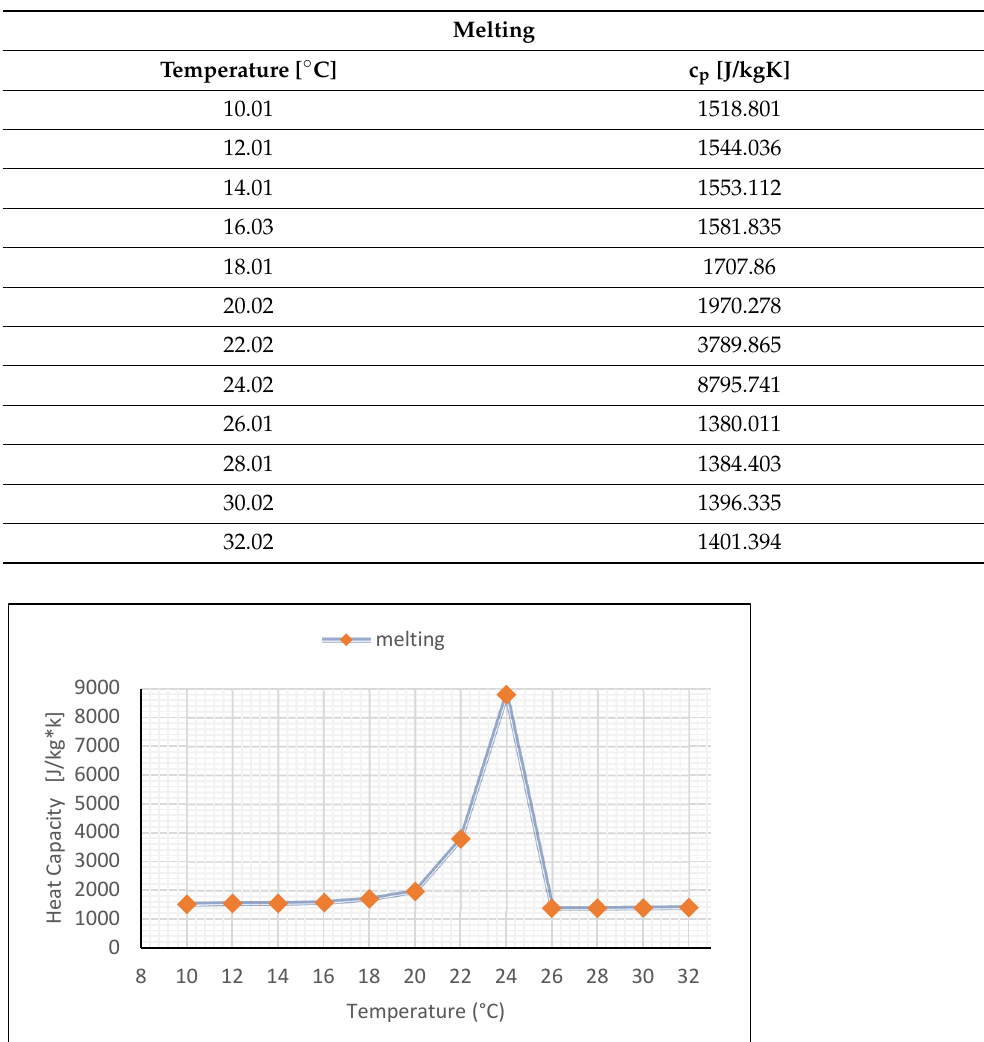
Figure 2. Mass thermal capacity of Micronal ® PCM SmartBoard™ 23, melting stage: 10–32 °C.